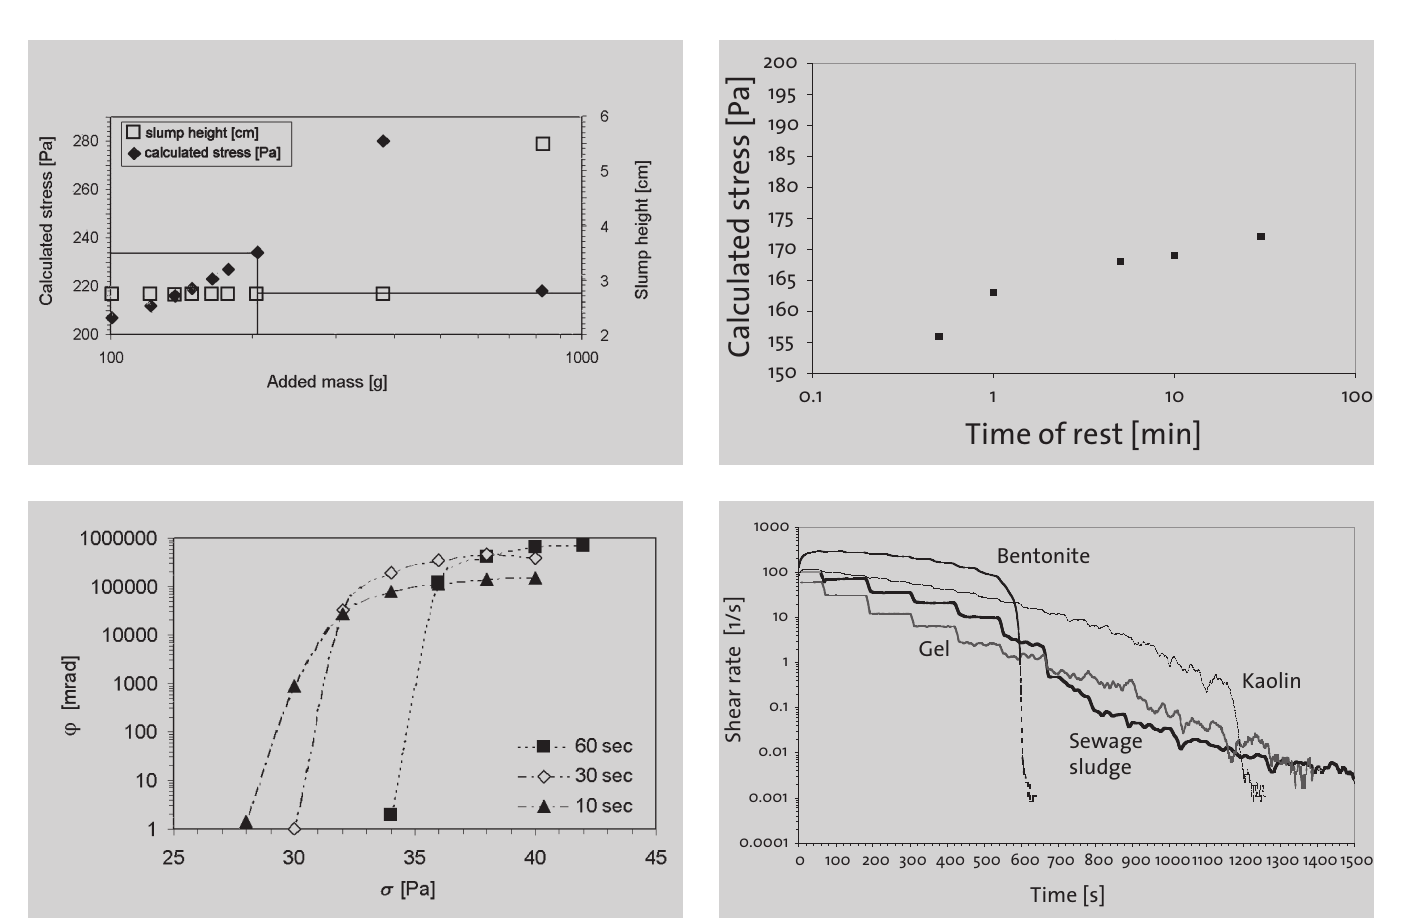
Figure 12 (left above): Final slump heights and corre- sponding calculated stress from slump test for a kaolin suspension with different masses added after stoppage with the smallest mass. Figure 13 (right above): Final stress calculated from the final slump for a kaolin sus- pension after different times of preliminary rest. Figure 14 (left below): Angle of rotation as a function of stress for a kaolin suspension sub- mitted to successively decreas- ing stress levels of different durations. Figure 15 (right below): Shear rate as a function of time when one-minute steps of decreasing shear stress are applied. All the samples have been presheared at 100 s-1 except the bentonite suspen- sion (250 s-1), during two min- utes. Stress run is from 33 to 26.2 Pa (bentonite) and from 39 to 25.5 Pa with steps equal to 0.75 Pa (kaolin); for sewage sludge: 90, 75, 67.5, 60, 52.5, 45, 42.8, 41.25, 40.65, 39.7, 39.1, 38.2 and 37.6 Pa; for hair gel (mixed with water here at